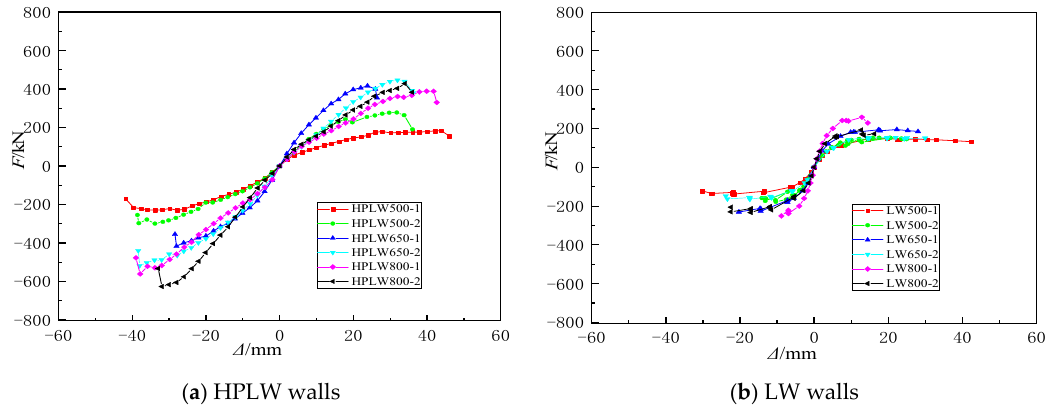
Figure 11. Skeleton curves of HPLW and LW